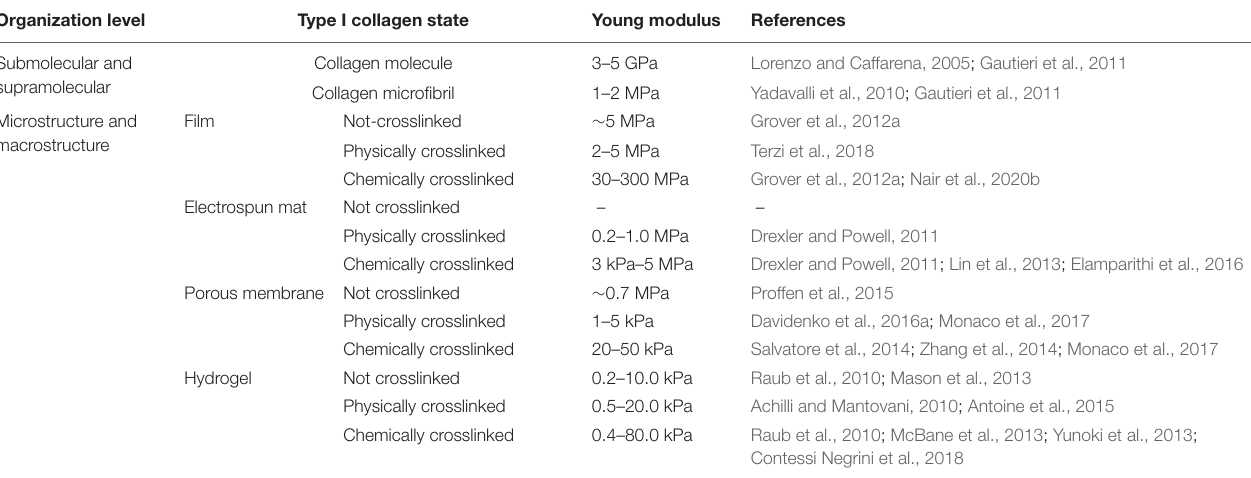
TABLE 5 | Young modulus of type I collagen in wet state at microscale and nanoscale, calculated as the slope of the tangent to the linear elastic region of stress–strain curves obtained by means of AFM or tensile